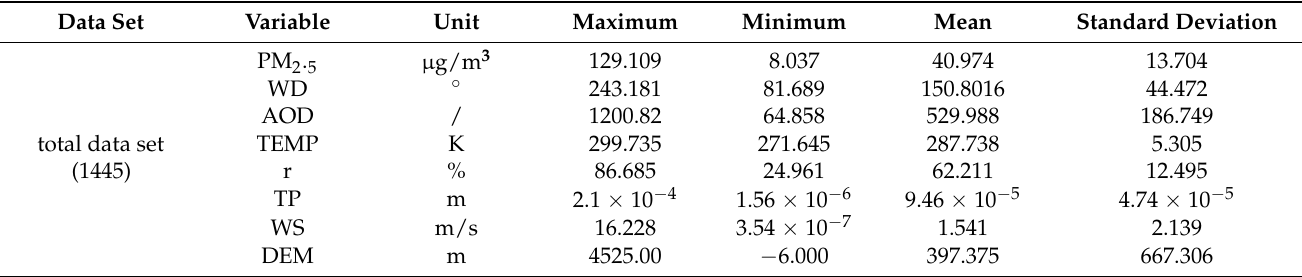
Table 1. Basic statistical information of the data set.